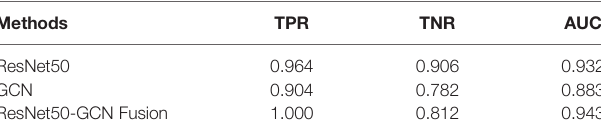
TABLE 2 | Comparison of classi fi cation results of clustered microcalci fi cation in different methods. Methods